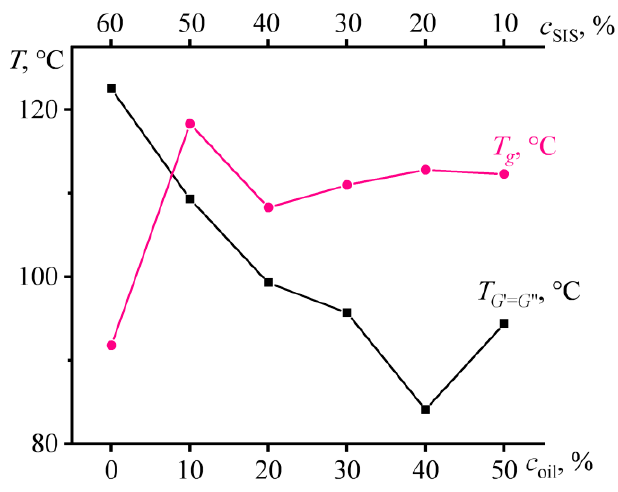
Figure 8. Concentration dependences of glass transition temperature and liquid–solid transition point for mixtures with different concentrations of naphthenic oil and styrene ‐ isoprene ‐ styrene triblock copolymer, while the concentration of asphaltene/resin blend (ARB) remains unchanged and equal to 40%.